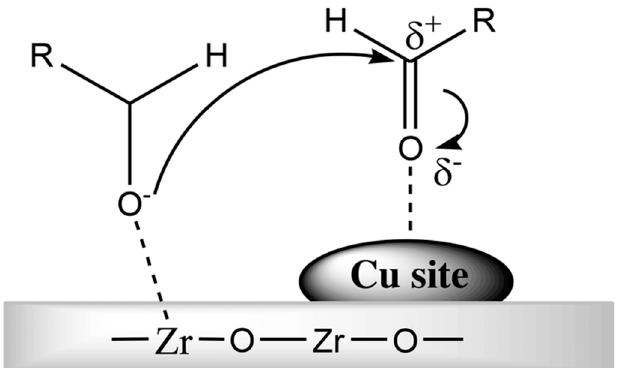
Figure 7. Suggested active site for the DHC reaction in which the acid–base pair is formed by a CuO Lewis acid site and ZrO 2 -based strong basic site. CuO promotes the dehydrogenation of the alcohol and activates the aldehyde towards the attack of a second alcohol molecule activated by the basic sites of ZrO 2 [5]. Reproduced by permission of The Royal Society of Chemistry.